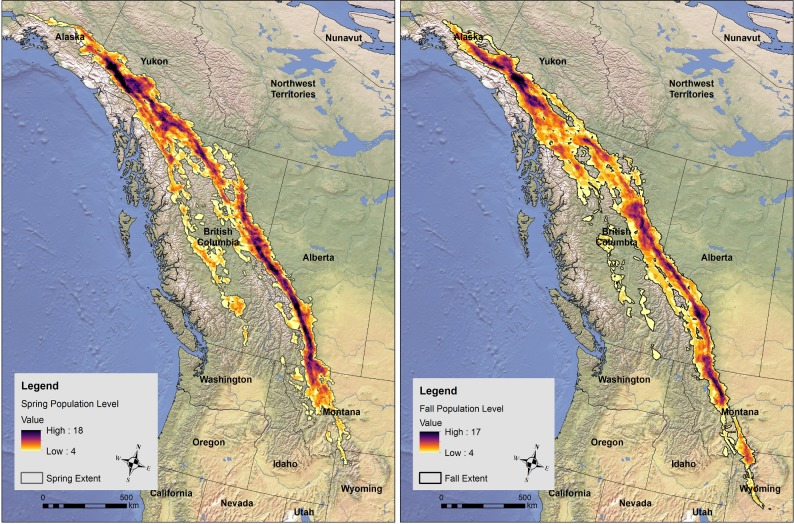
Population-level migration corridors of adult Golden Eagles during spring (left) and fall (right) migrations (2011–2016).Values within the spatial extent represent the number of overlapping individual eagle utilization distributions within each 2.5 km2 cell. The spatial extent was determined by a minimum of 10% of the sample population overlapping.